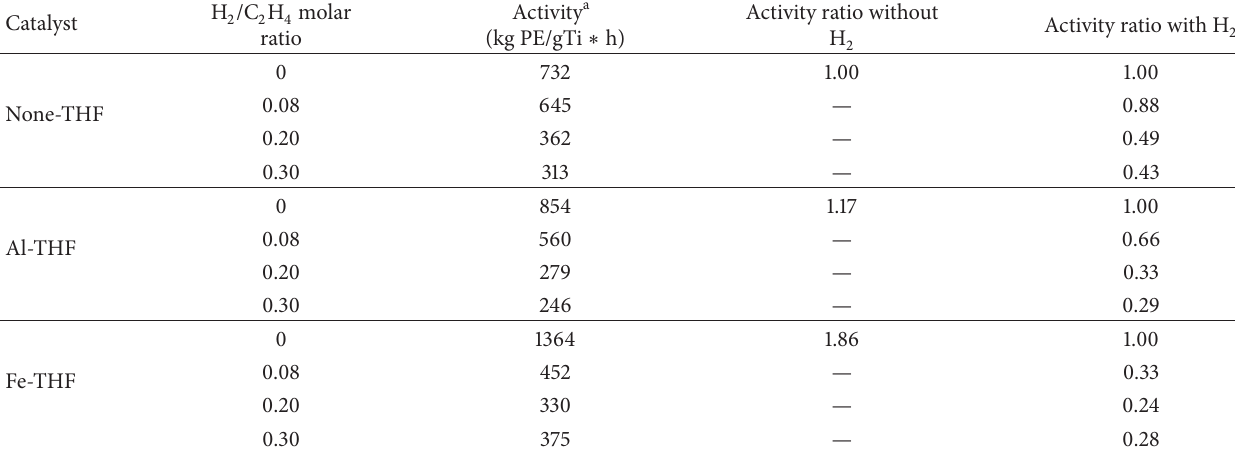
Table 3: Catalytic activity of different doped Lewis acid catalysts in ethylene polymerization.